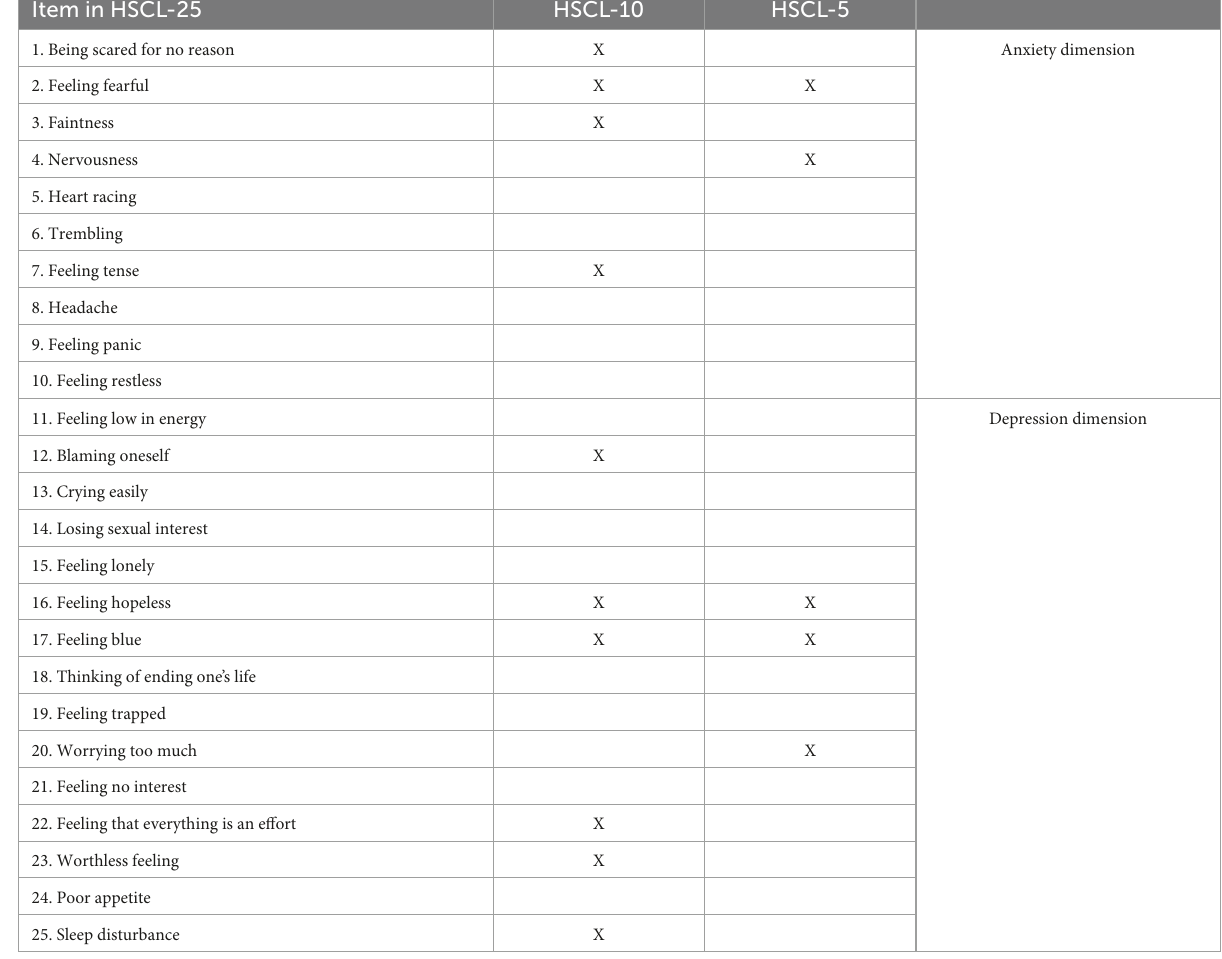
TABLE 1 Items belonging to HSCL-25, HSCL-10, and HSCL-5 scale. Item in